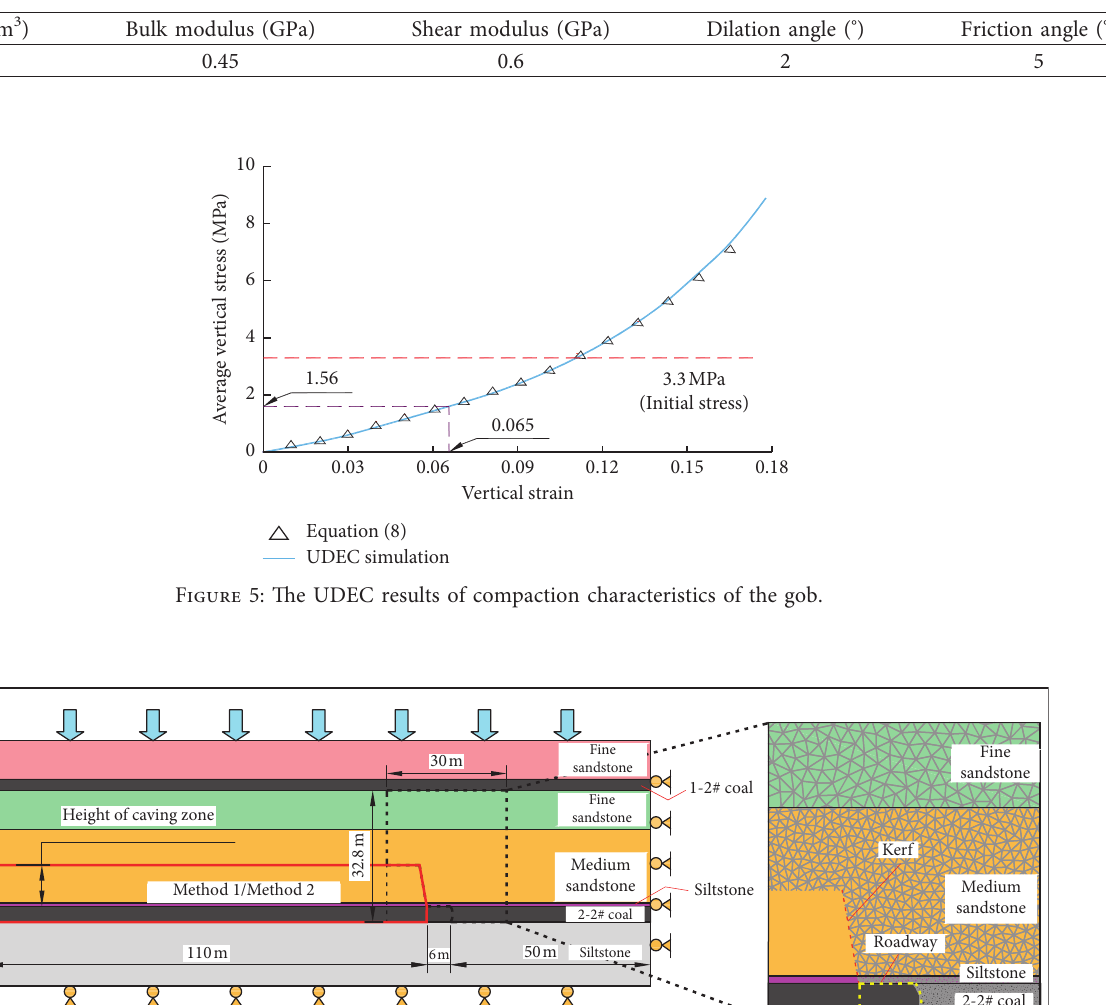
Table 2: Material parameters of gob.